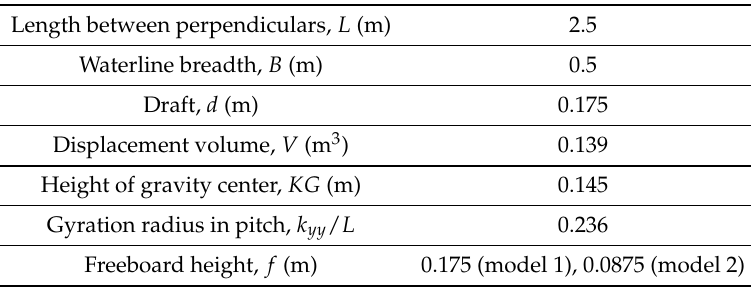
Figure 1. Forward views of the blunt Wigley hull models. Table 1. Principle parameters of the ship